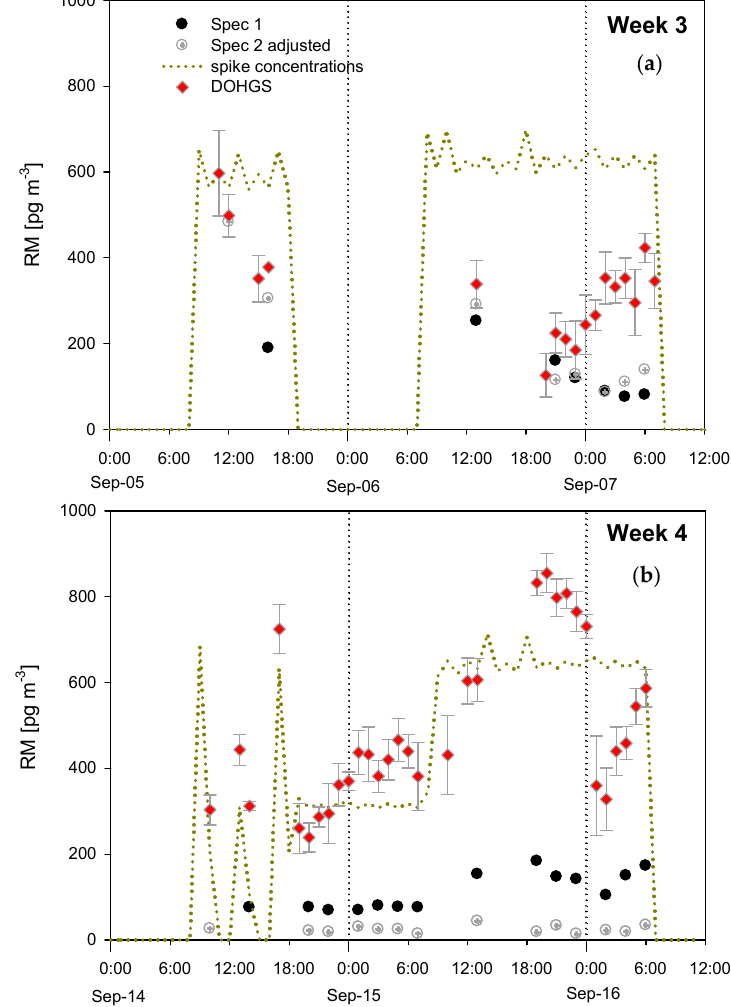
Figure 2. Hourly mean reactive mercury (RM) concentrations during Reno Atmospheric Mercury Intercomparison eXperiment (RAMIX) measured by two Tekran systems (Spec 1, Spec 2) and Detector for Oxidized mercury System (DOHGS) during HgBr 2 spikes. ( a ) Week 3; ( b ) Week 4. During week 3, both Tekran systems were sampling from the manifold, whereas in week 4, only Spec 1 was sampling from the manifold. Spec 1 and Spec 2 data represent a single hourly measurement, and the DOHGS data represent a 1-hour average of measurement made every 2.5 min. The error bars on DOHGS data represent 1 σ . Reprinted (adapted) with permission from [28]. Copyright (2013) American Chemical Society.